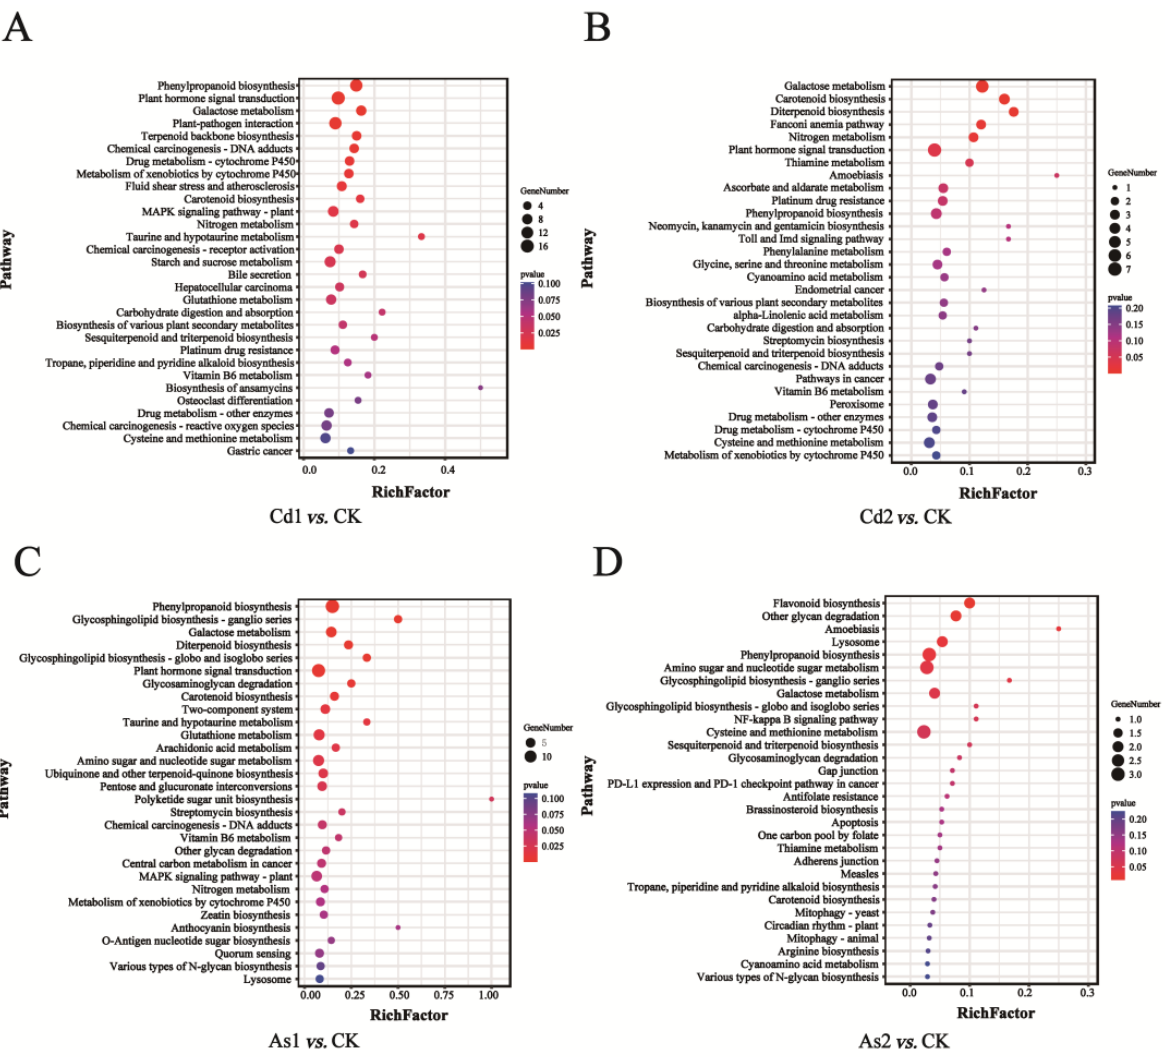
Figure 4. Identification and KEGG enrichment of DEGs. ( A – D ) Top 25 KEGG enrichment results of DEGs in four different pairwise comparisons. ( A ) Cd1 vs. CK; ( B ) Cd2 vs. CK; ( C ) As1 vs. CK; ( D ) As2 vs. CK. CK, control group; Cd1 and Cd2 indicate the tea roots treated with Cd for 10 and 15 days, respectively; As1 and As2 indicate the tea roots treated with As for 10 and 15 days, respec- tively.